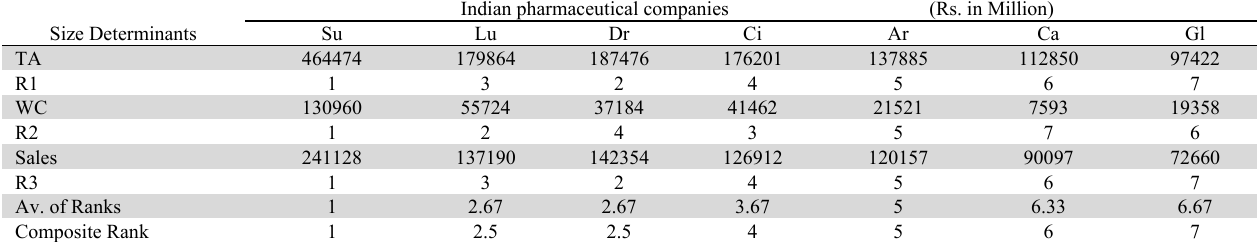
Size & Rankings of the leading selected Indian pharmaceutical companies Size